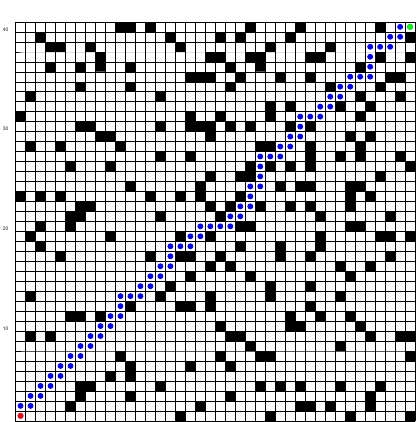
Fig. 2. Experimental results of improved Q-learning.